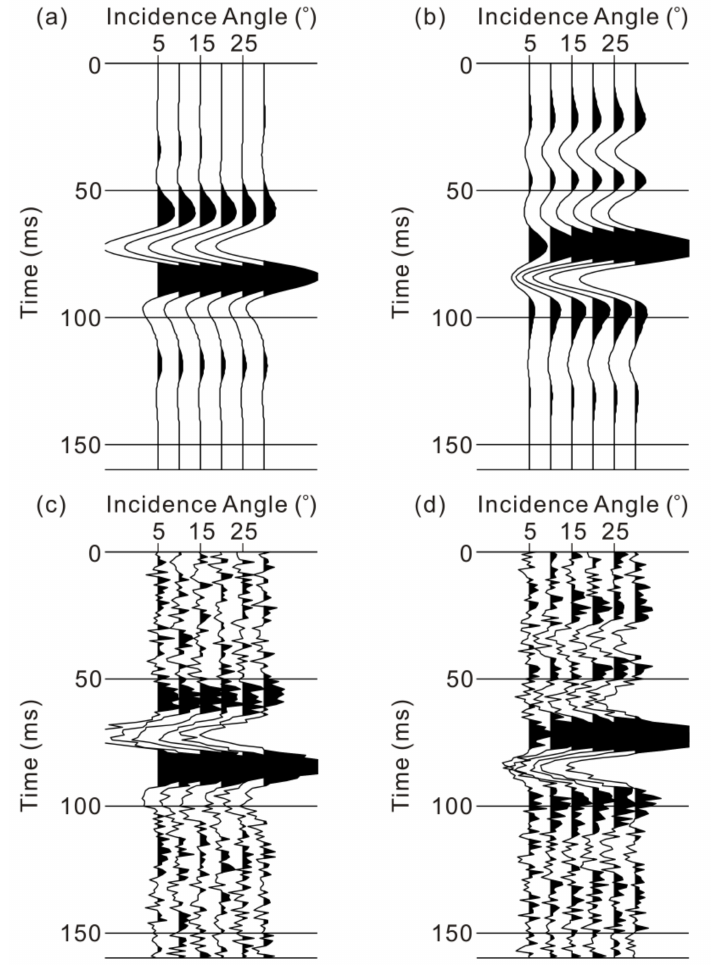
Figure 5. Synthetic AVA gathers: ( a ) pure PP-waves; ( b ) pure PS-waves; ( c ) PP-waves with a random noise level of 10%; and ( d ) PS-waves with a random noise level of